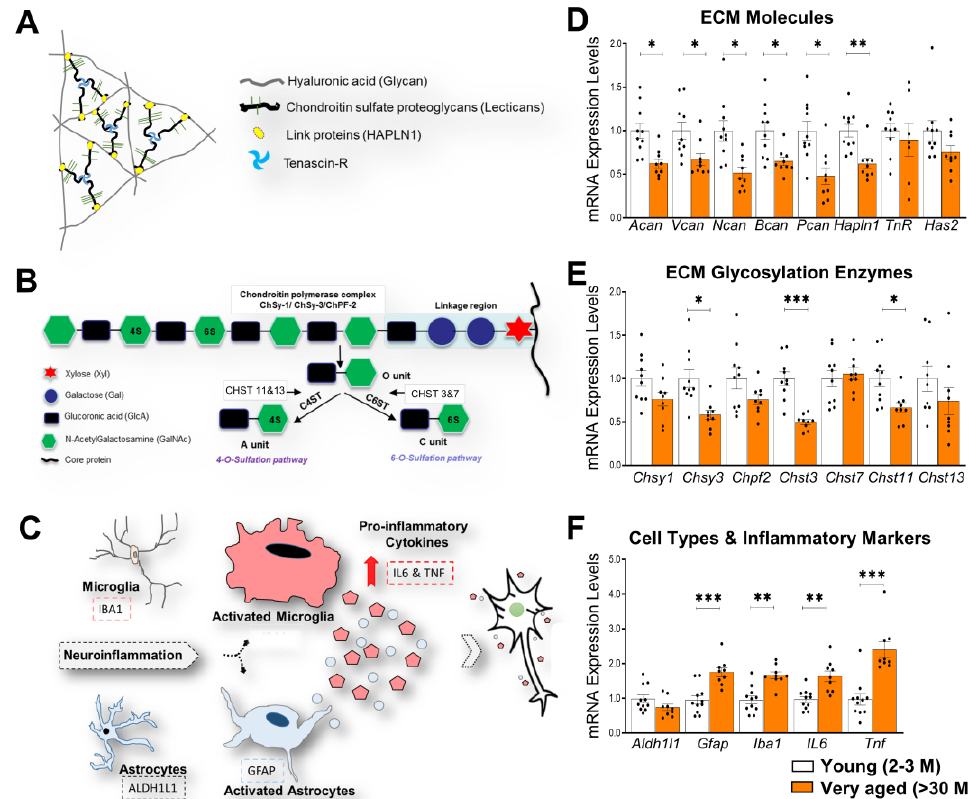
Figure 1. Downregulated ECM mRNA in the right hippocampus of >30 M-old mice. ( A ) Scheme depicting the basic principle of neural ECM organization. ( B ) GAG chains attached to core proteins of various types of CSPGs (e.g., aggrecan) are polymerized by the chondroitin polymerase complex which includes the chondroitin synthases 1 and 3 (Chsy1&3), and chondroitin polymerizing factor 2 (Chpf2). Unsulfated disaccharides (O unit) of GAG chains are further modified with sulfates yielding C4S (A unit) and C6S (C unit) by chondroitin 4-sulfotransferase (C4ST) and chondroitin 6-sulfotransferase (C6ST), respectively. ( C ) Neuroinflammatory microenvironment. ( D ) Genes encoding for core proteins of CSPGs; Acan , Vcan , Ncan , Bcan , and Pcan , were downregulated in >30 M-old mice compared to 2-32-3 M-old mice. ( E ) In >30 M-old mice, glycosylation enzymes were analyzed and C6 sulfotransferase Chst3 was found to be downregulated compared to 2-3 M-old mice. ( F ) Inflammatory cytokines and markers for glial activation were upregulated in >30 M-old mice, a characteristic feature of aging, compared to 2-3 M-old mice. Bar graphs show mean ± SEM values. * p < 0.05, ** p < 0.01, and *** p < 0.001 represent significant differences between 2-3 M-old mice ( n = 10) and >30 M-old mice ( n = 9).